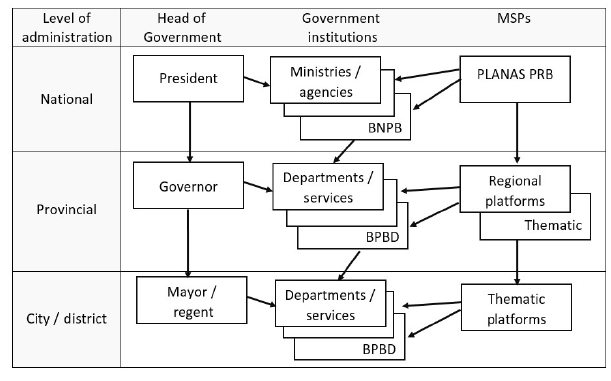
Figure 2. Institutional structure for DRR in Indonesia (adapted from COE-DMHA,